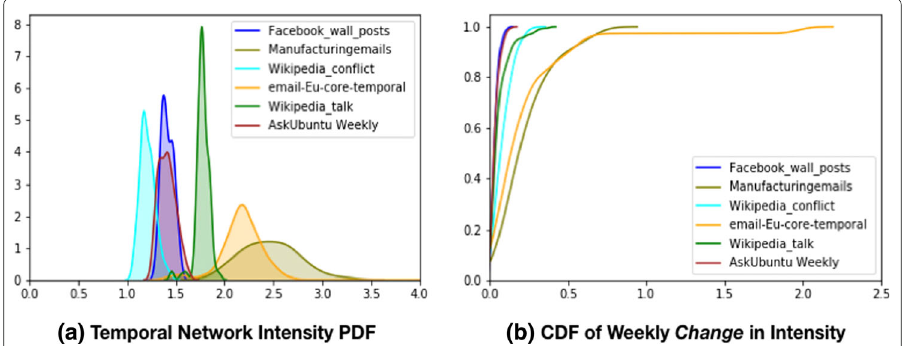
Fig. 3 Aggregated network measures: a The PDF of the weekly Temporal Network Intensity for each dataset. b The cumulative distribution of the relative change in the measured Temporal Network Intensity between every two consecutive weeks for each